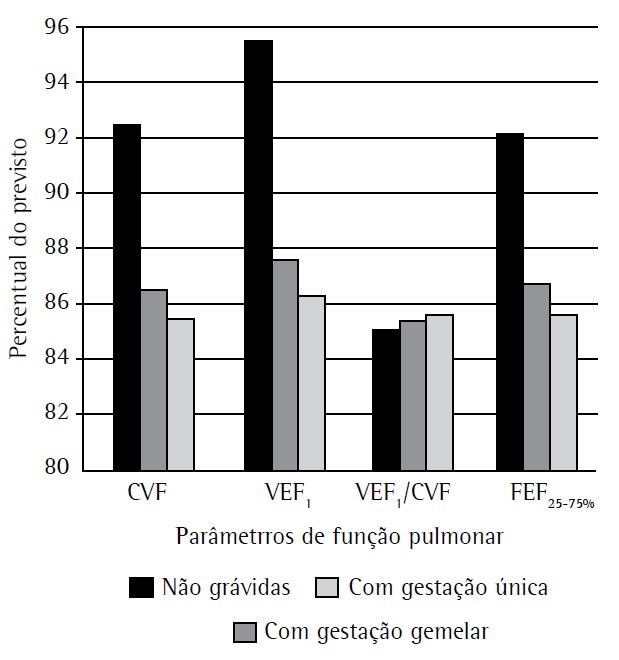
 Comparação dos parâmetros de função pulmonar entre os três grupos
avaliados.